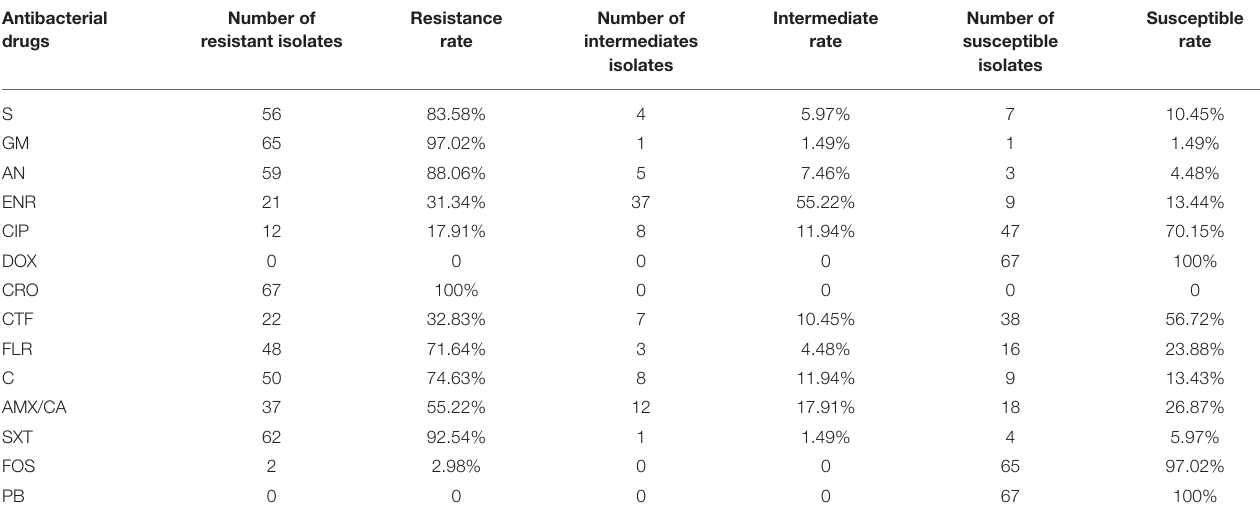
TABLE 3 | The resistance rate of 67 pathogenic E. coli isolates to 14 antibiotics. Antibacterial drugs